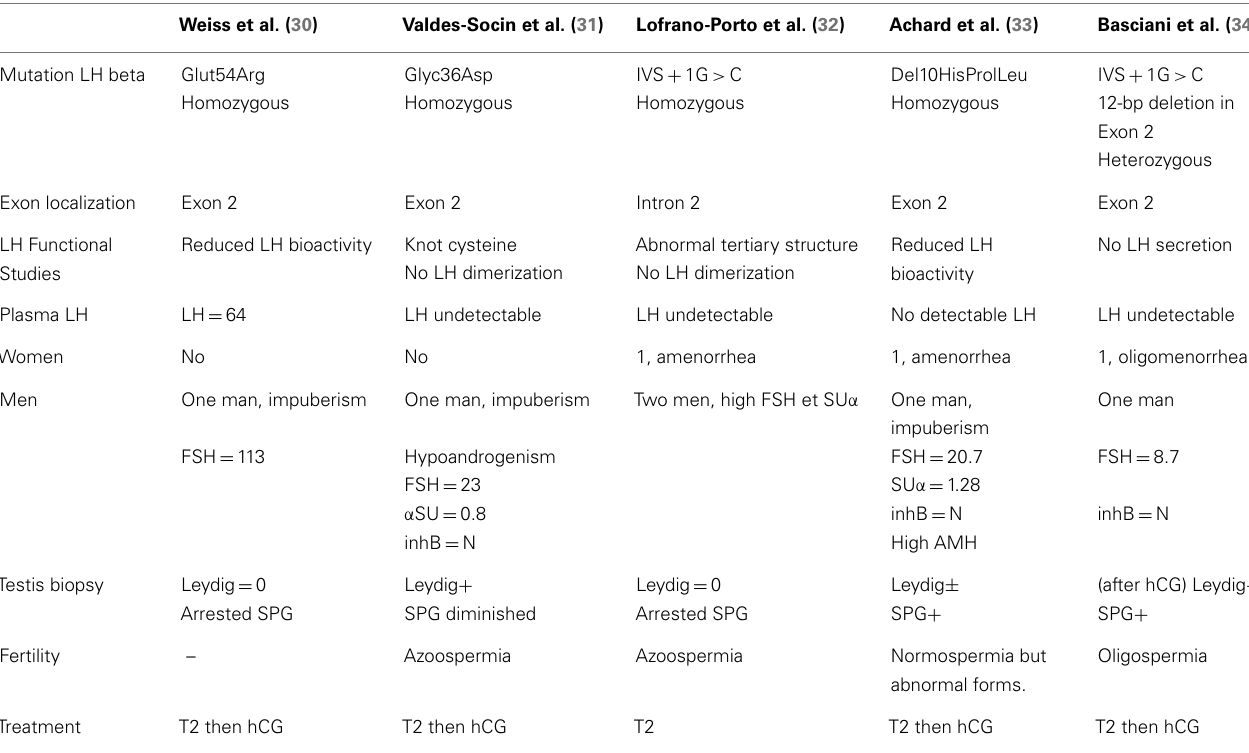
Table 3 | Clinical, biological, pathological, and genetic studies in patients with LH deficiency . Weiss et al. (30)